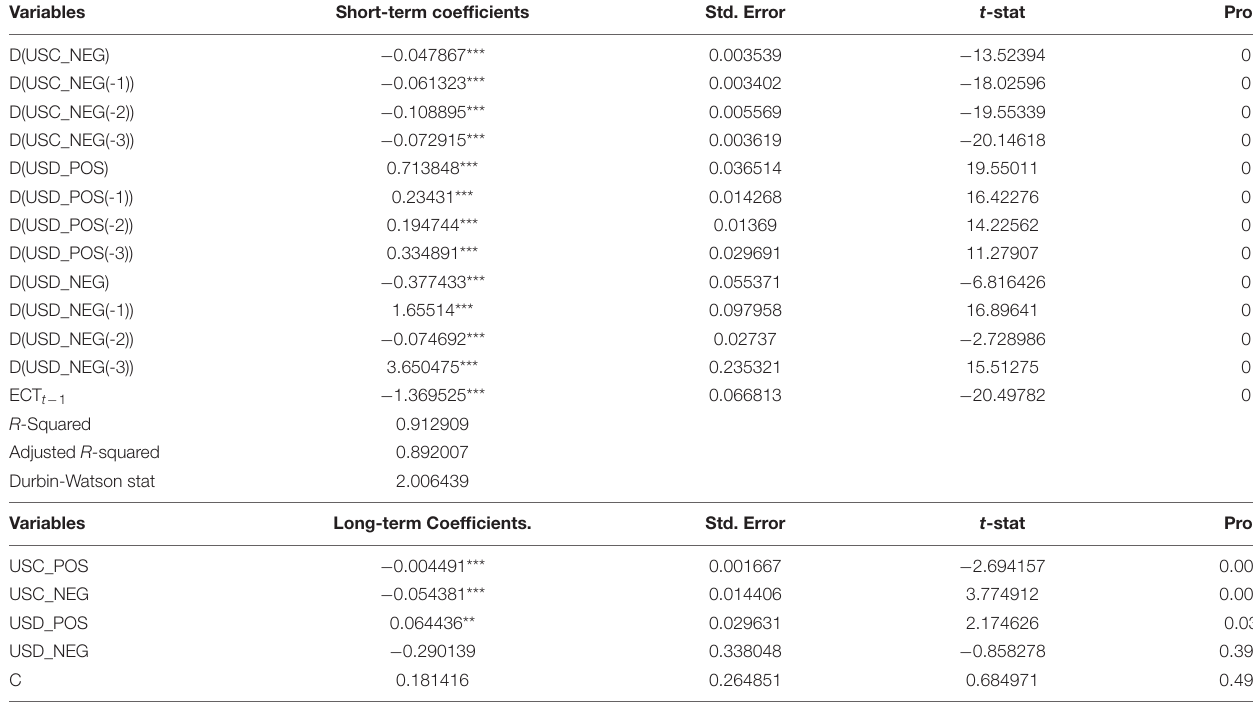
TABLE 5 | Asymmetric parameters of SPR.